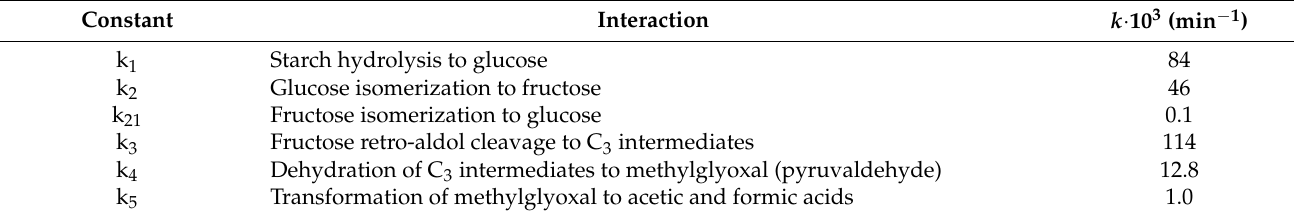
Dehydration of C 3 intermediates to methylglyoxal (pyruvaldehyde) Transformation of methylglyoxal to acetic and formic